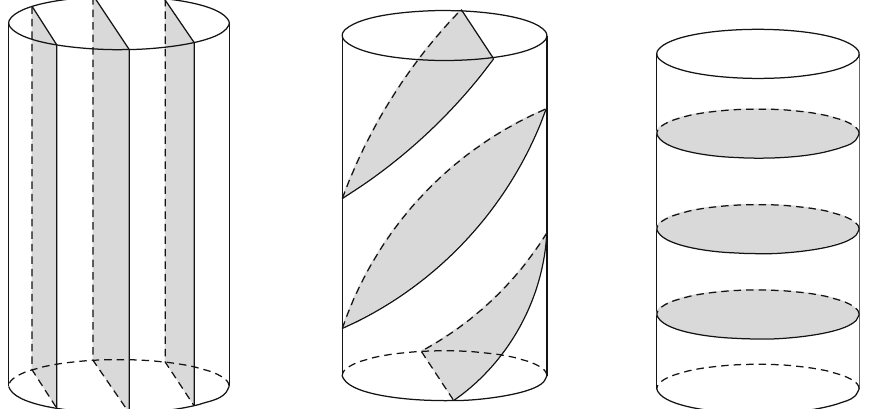
Figure 1: Schematic diagram of coal beddings.